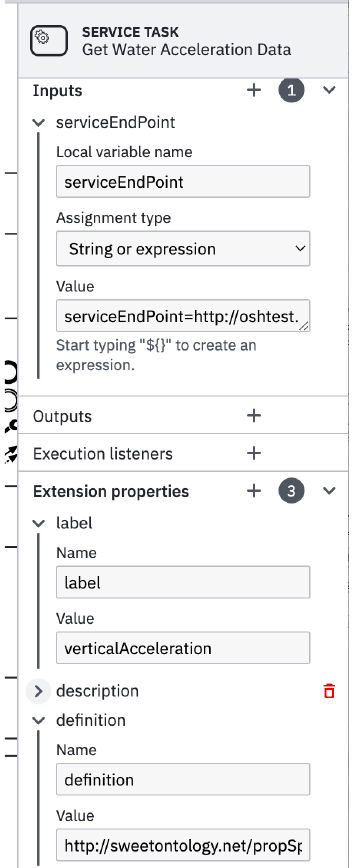
Figure 16. Specification of IoT-related properties in